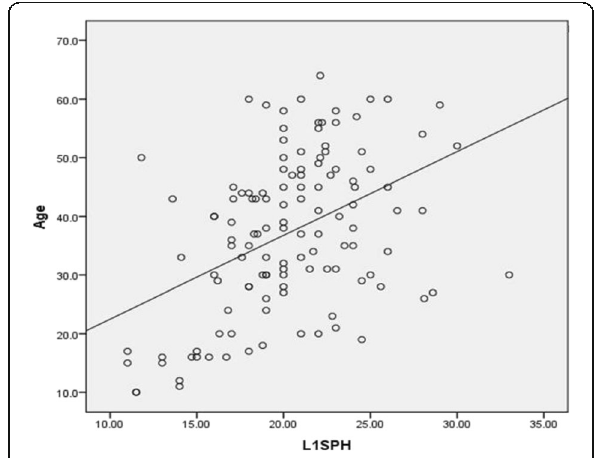
Fig. 2 Correlation between age and SPH of